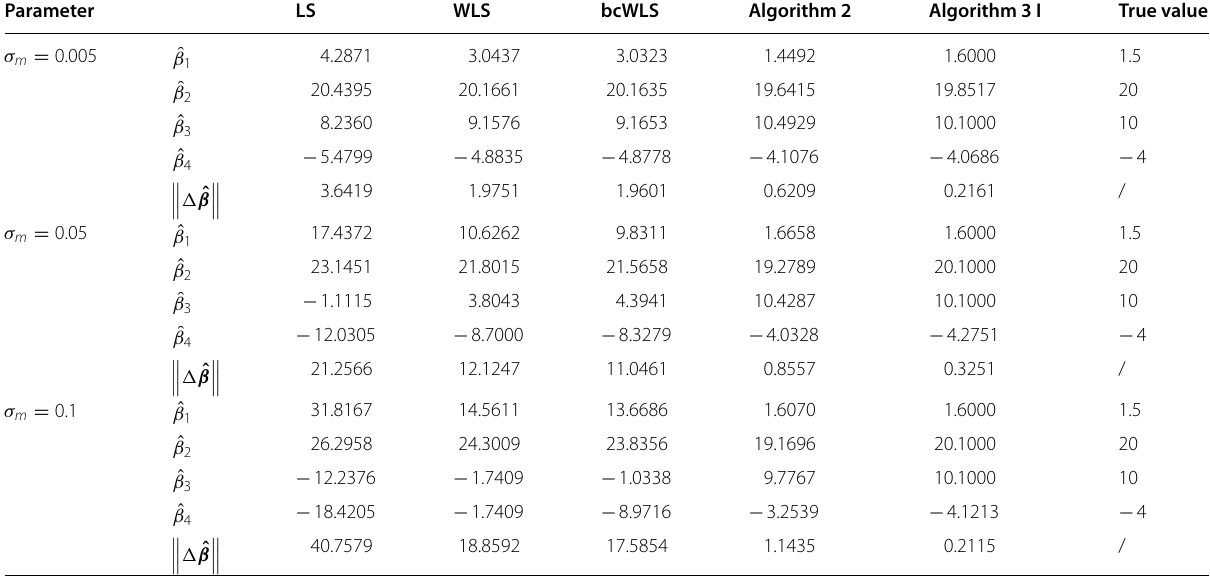
Table 7 Parameter estimates and the 2-norm results between the parameter estimates and true values for the third example Parameter LS WLS bcWLS Algorithm 2 Algorithm 3 I True